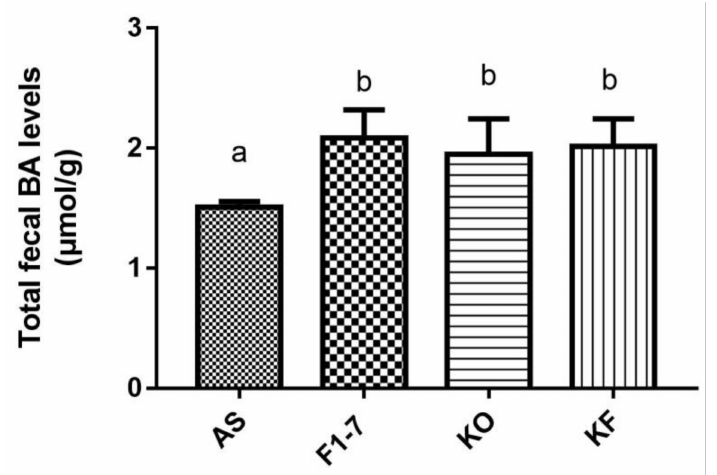
Figure 4. Total bile acid (TBA) levels of mice in feces (n = 4). Different letters indicate significance ( p < 0.05).